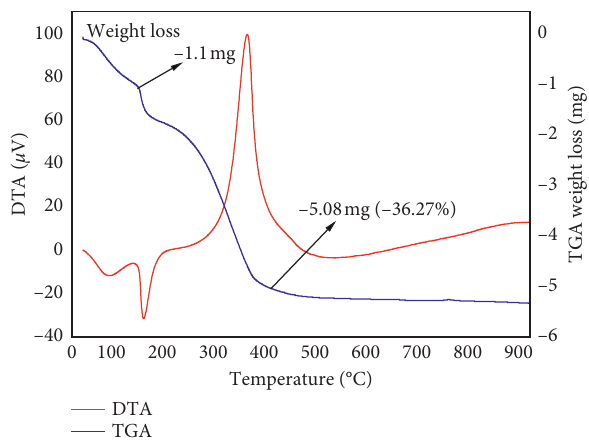
Figure 1: Thermal analysis of as-synthesized ZnO NPs using zinc acetate dihydrate and Lippia adoensis leaf extract in 9:1 ratio.